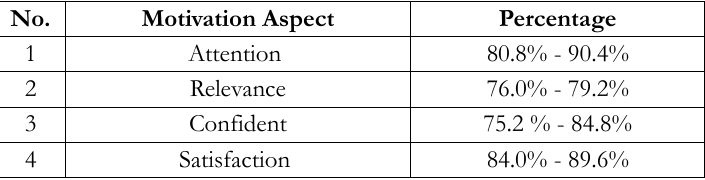
Table 6. Results of Students’ Learning Motivation